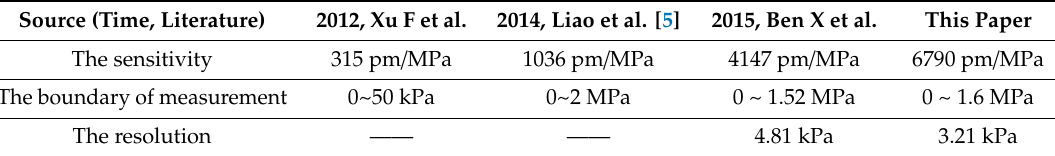
Figure 12. Wavelength deviation of central interference peak under pressure change. Table 1. The sensitivity of optical fiber Fabry–Perot pressure